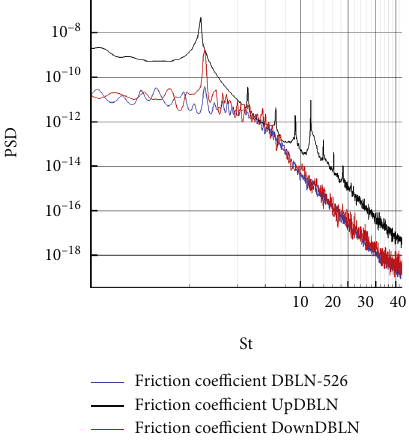
Figure 32: PSD of friction coe ffi cient ( Re = 0 : 8 E 6 , α = 0 ° ).